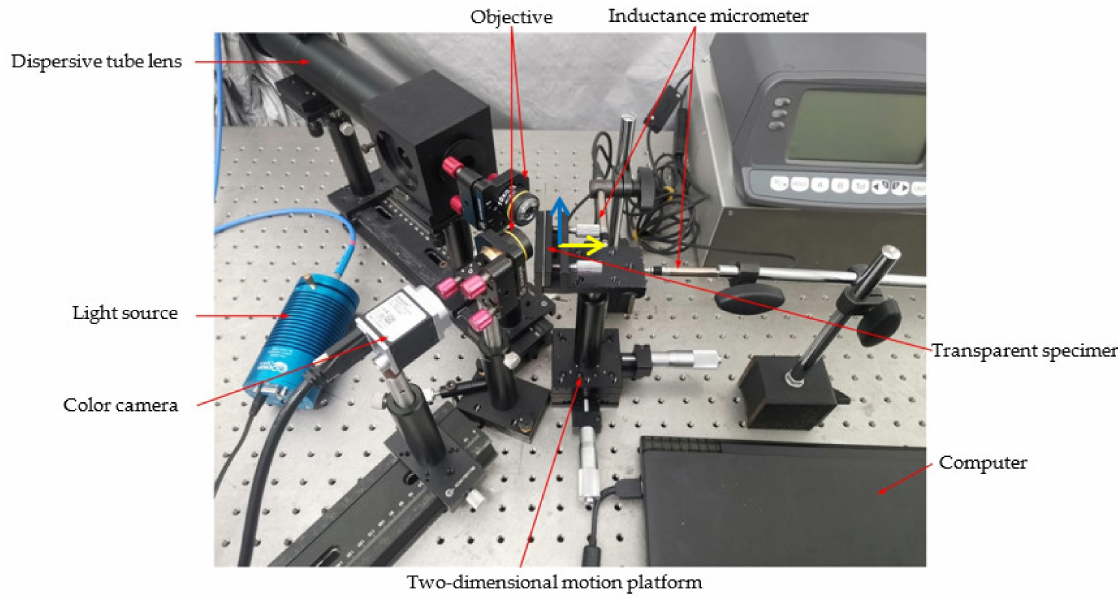
Figure 9. Diagram of chromatic confocal system with inclined